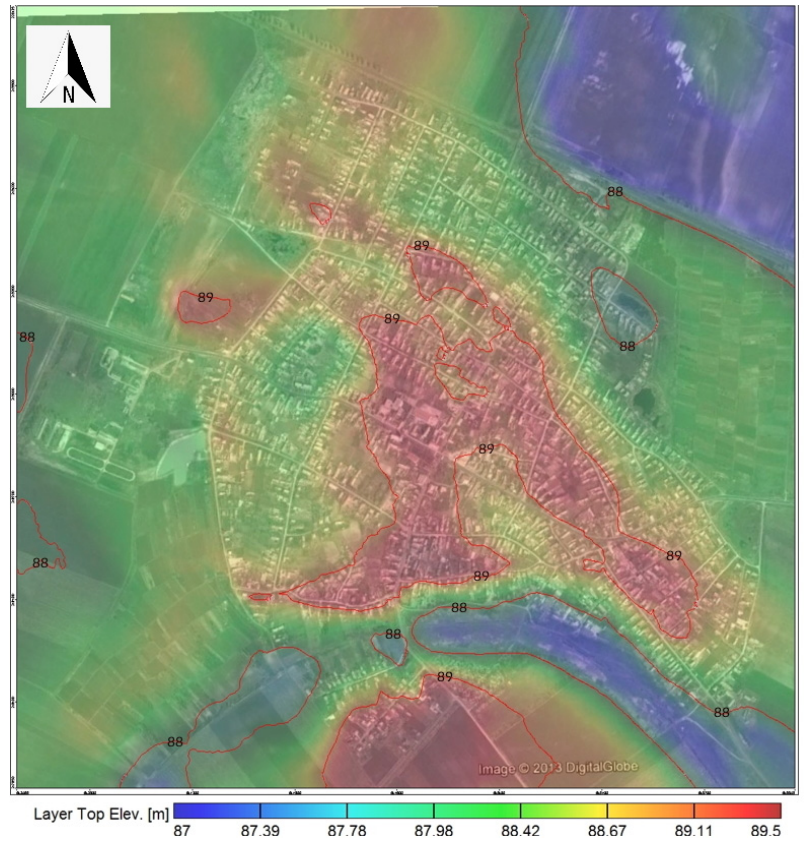
Figure 3. Digital relief map of the investigated settlement.